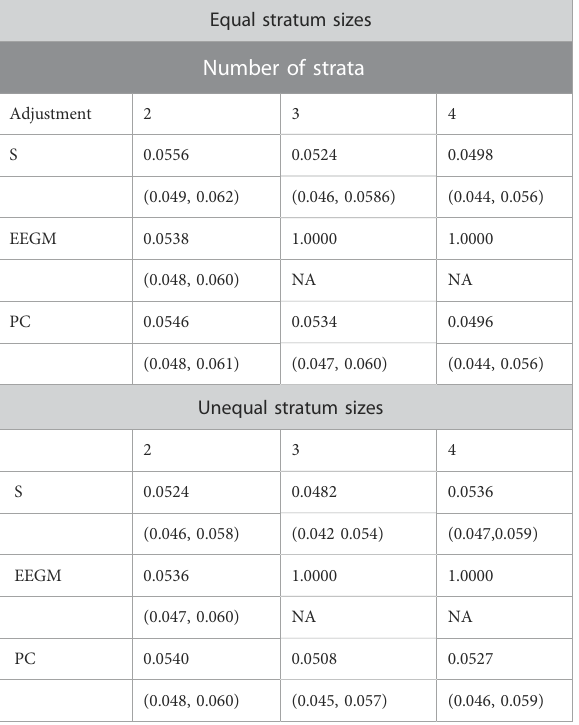
TABLE 2 Estimated type 1 error rates (top entry) and corresponding 95% con fi dence intervals (bottom entry) when data are simulated from 2, 3 or 4 strata with equal (top three rows) or unequal (bottom three rows) stratum